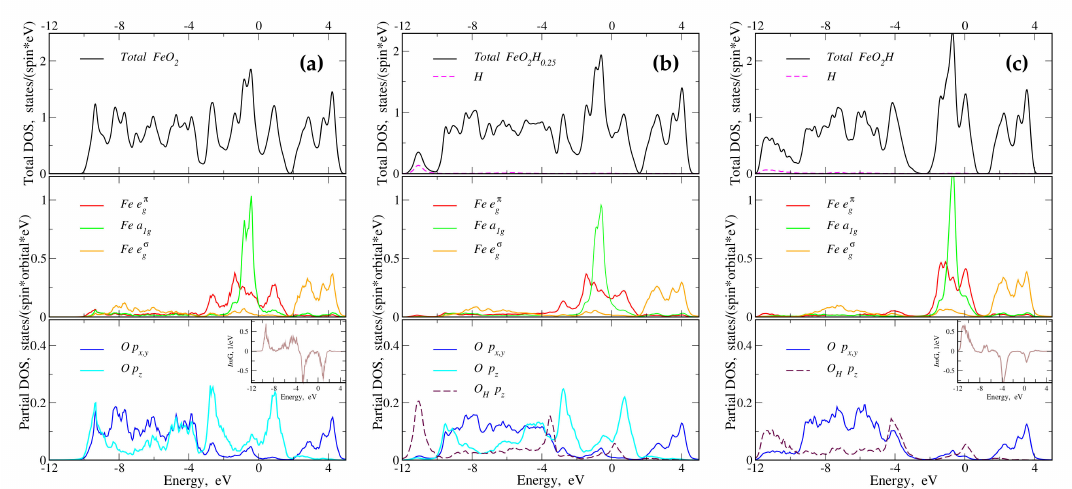
Figure 2. (Color online) The total and partial density of states for FeO 2 H x . ( a ) Pure FeO 2 , ( b ) FeO 2 H 0.25 , and ( c ) FeO 2 H. Top panels: the total density of states (DOS) is in black. The H states are shown by the dashed magenta color. Middle panels: the orbital resolved partial DOS of iron. The red, green, and orange colors represent the e π g , a 1 g and e σ g states, respectively. Lower panels: the orbital resolved partial DOS of oxygen. The blue color shows the double degenerate p x and p y states, and the cyan color is for p z orbital. The insets in the bottom panels show the imaginary part for the off-diagonal Green function in the pair of the nearest oxygen atoms (closest to H1